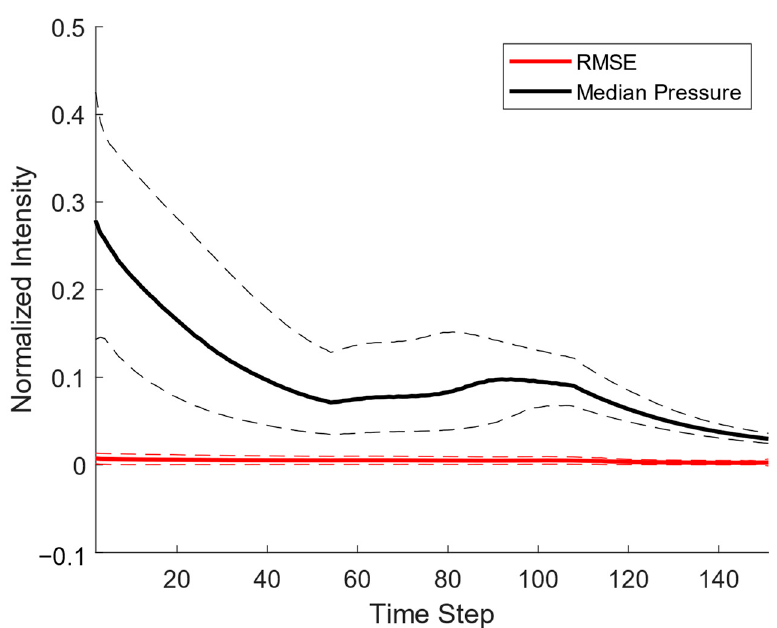
Figure 4. RMSE and standard deviation bands between the k-Wave and FNO simulations on the breast vasculature test dataset. Distribution of pressures (25th, 50th and 75th percentiles) are provided as a frame of reference.